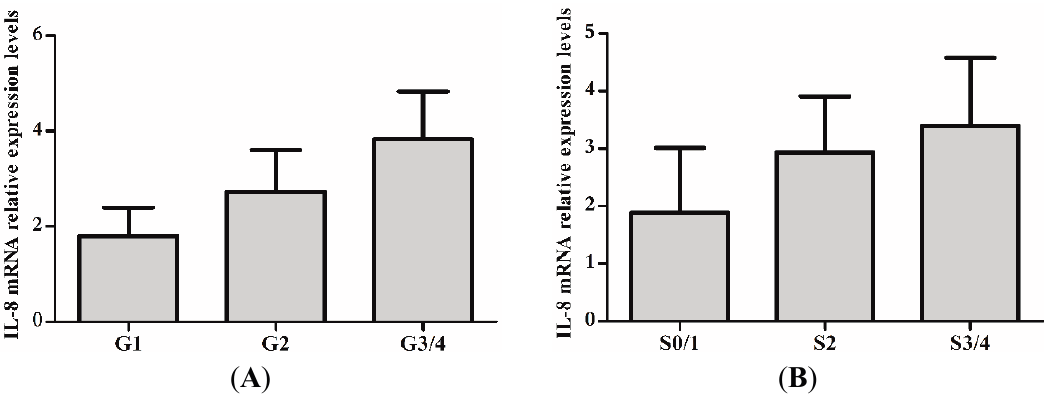
Figure 2. mRNA expression of IL-8 in Peripheral Blood Mononuclear Cells (PBMCs) of CHB with different hepatic inflammation stages or fibrosis grades. ( A ) Detection of IL-8 mRNA in PBMCs of CHB with different hepatic inflammation stages by RT-qPCR; ( B ) Detection of IL-8 mRNA in PBMCs of CHB with different hepatic hepatic fibrosis grades by